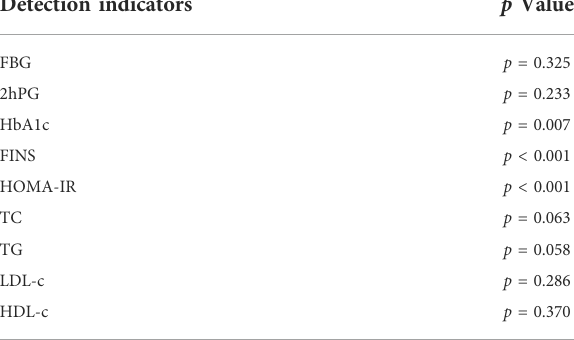
TABLE 5 Egger ’ s publication test of the trials thatcompared HLPs plus metformin vs. metformin. Detection